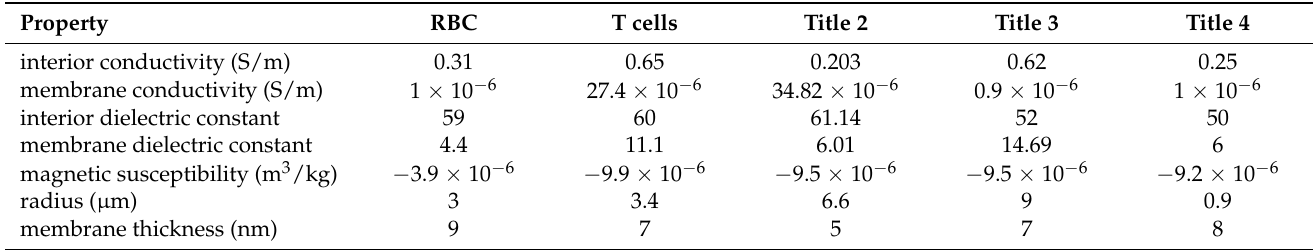
Table 2. Physical-chemical properties of the cells used in the simulation [29,62,66–70].